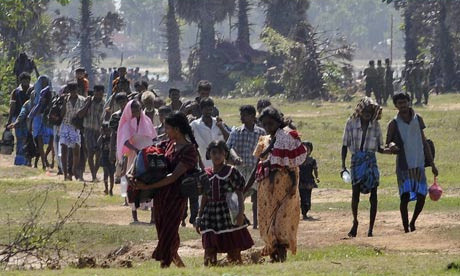
Treacherous Pathways [86].